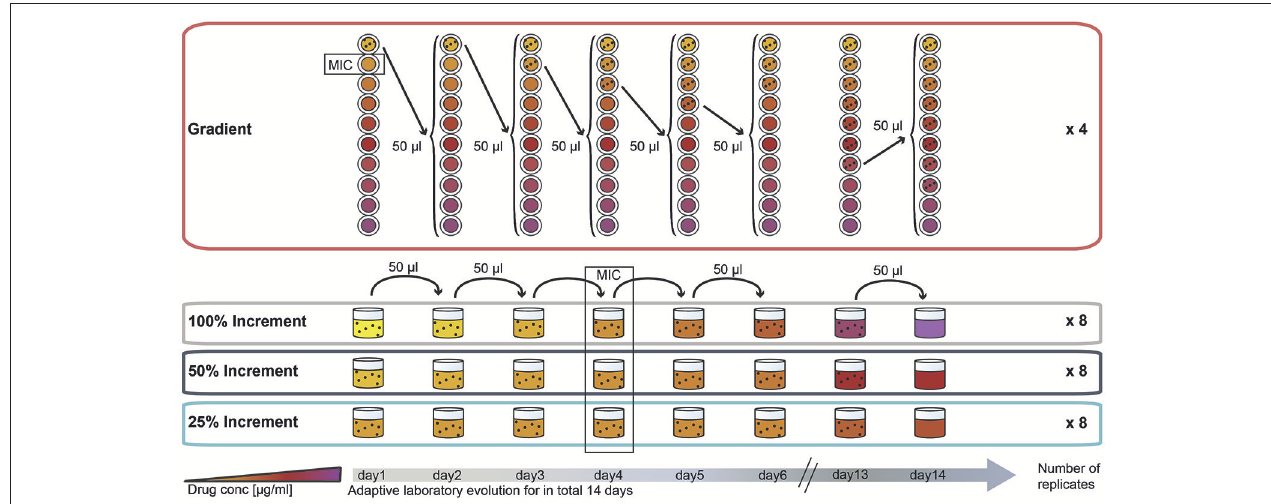
FIGURE 1 | Experimental design of the study: adaptation of E. coli K12 to three antibiotics following four adaptation protocols with different selection strengths. The four selection systems are named “gradient,” “100% increment,” “50% increment,” and “25% increment.” In the gradient approach, cells were inoculated into a 2-fold, 10-step drug gradient and cells growing in the highest concentration were used for inoculation of a fresh gradient. In the increment approaches the drug concentration was raised with every transfer either by 100, 50, or 25%. The wild type minimal inhibitory concentration (MIC) was reached on the fourth day of the experiment for all increment